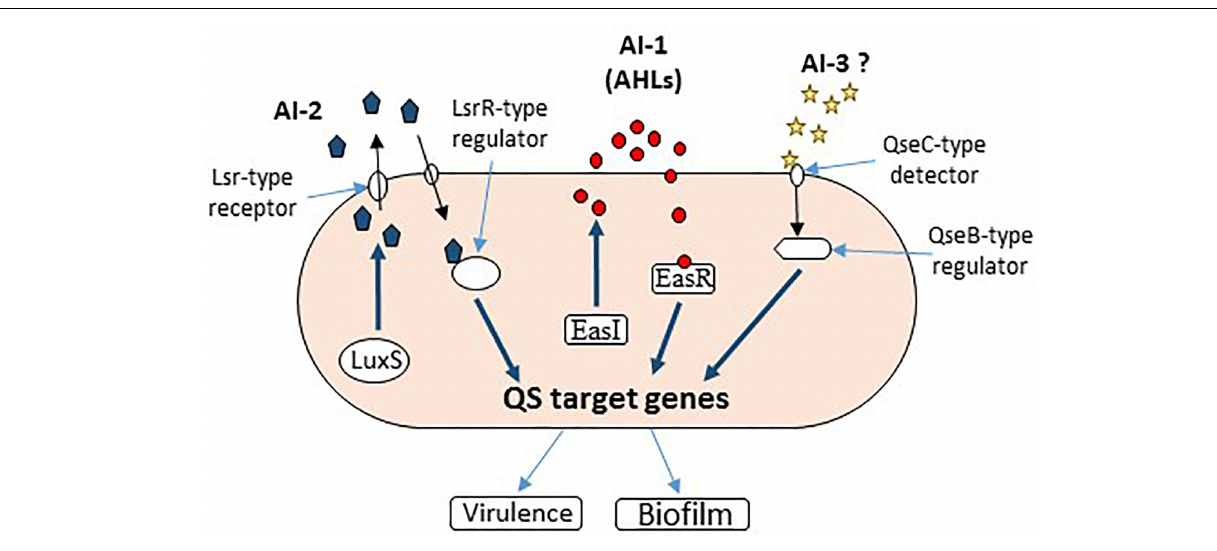
FIGURE 3 | Quorum sensing signaling in Enterobacter sp. All three AIs have been reported to function in Enterobacter sp. (AI-1, AI-2, and